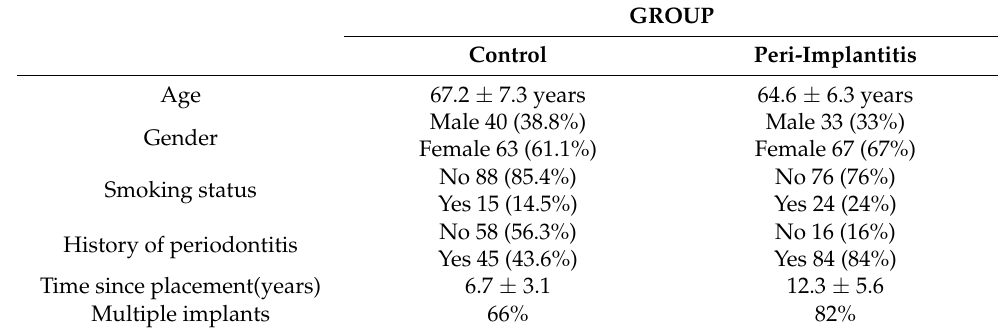
Table 1. Individual characteristics of the patients.